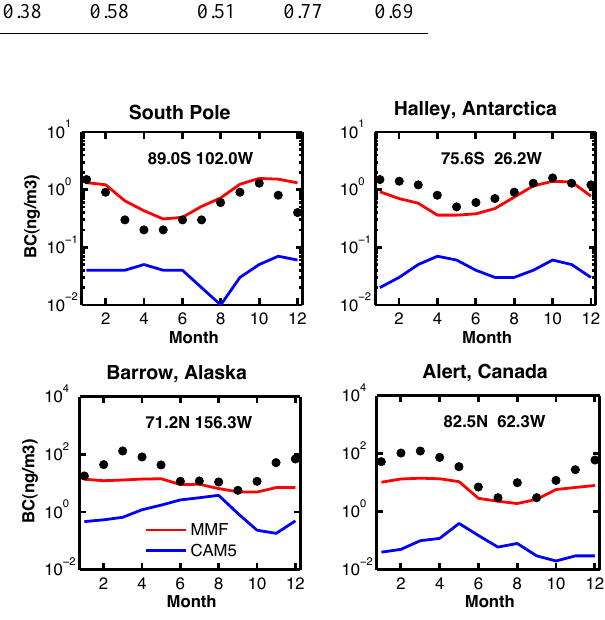
Figure 08 Fig. 8. Monthly-average BC concentrations at four polar sites: (a) Amundsen-Scott, South Pole (Bodhairne, 1995); (b) Halley, Antarctica (Wolff and Cachier, 1998); (c) Barrow, Alaska (Bod- haine, 1995); and (d) Alert, Canada (Hopper et al., 1994). PD model results are in solid lines (red: MMF; blue: CAM5), and ob- served data are in